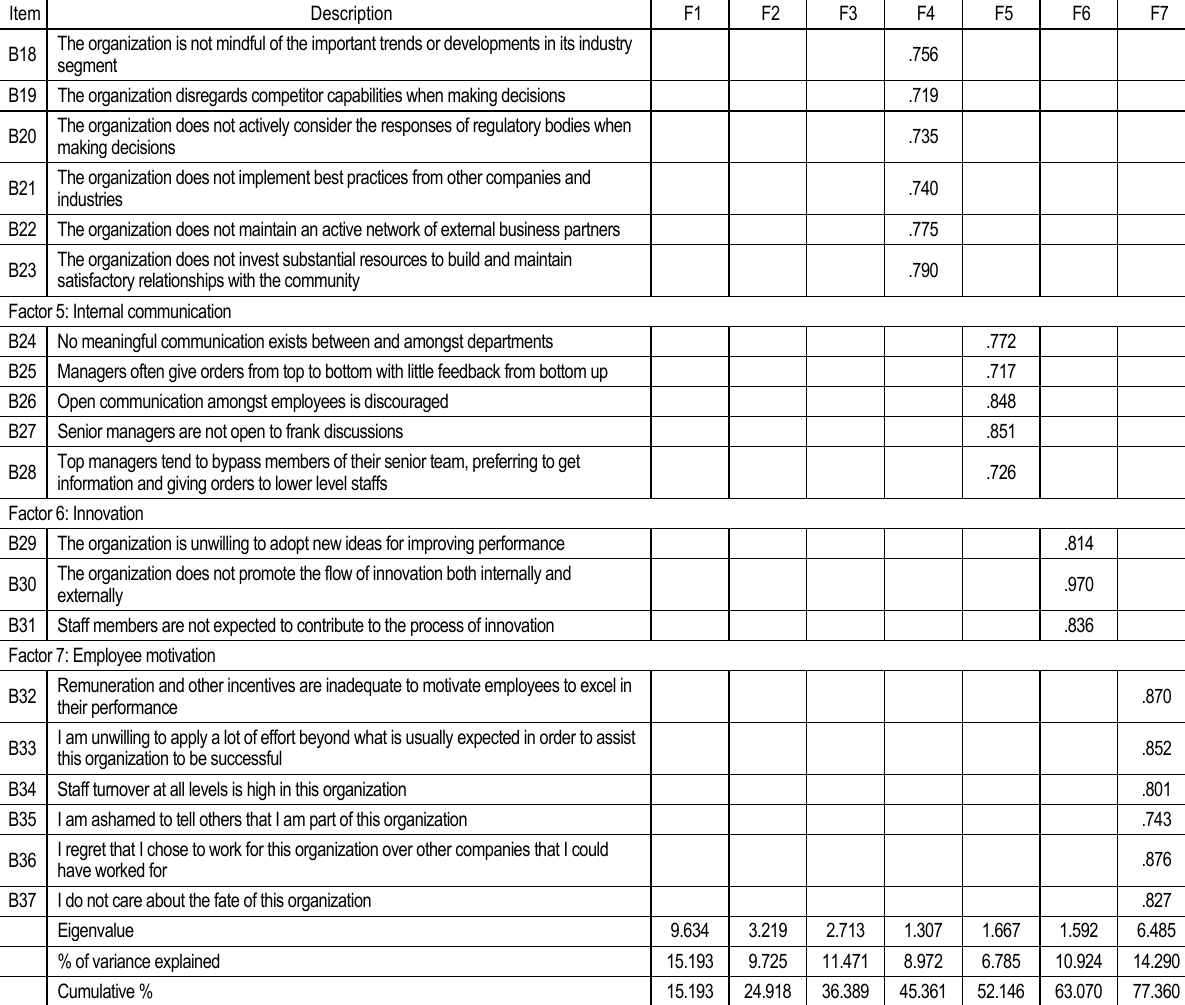
Table 1 (cont.). Rotated component matrix: barriers to strategy